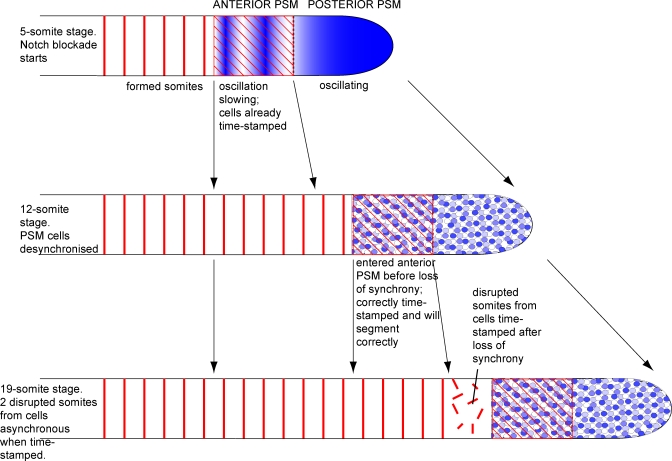
Cartoon to Show Why Somite Boundary Defects Appear only After a Long Delay Following Blockade of Notch Signaling